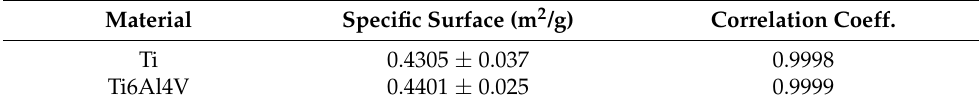
Figure 4. Granulometry of the particles released. Table 2. Specific surface of the Ti and Ti6Al4V particles.